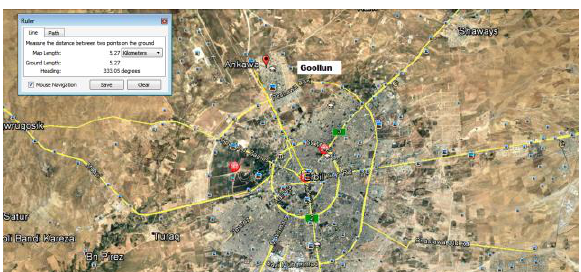
Figure 4. The location of Goollun City housing project. Source: Google